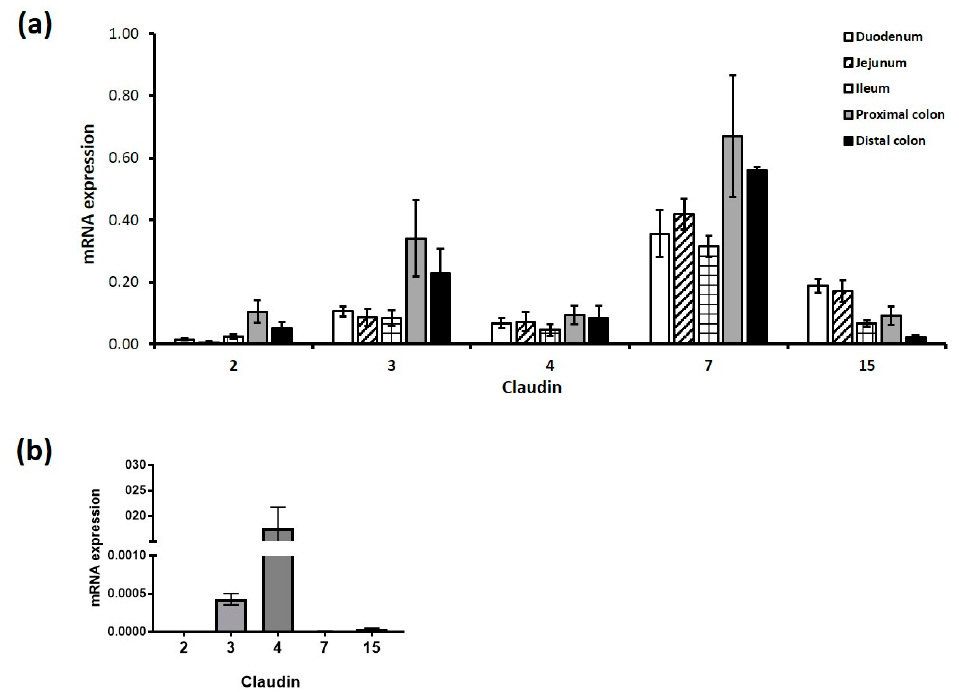
Figure 3. Claudin mRNA expression profile in the intestinal epithelium in vitro and in vivo. Claudin mRNA transcripts were profiled in the small and large intestine and in cultured Caco-2 cells. ( a ) Three segments of the murine small intestine, the duodenum (stomach to ligament of Treitz), the jejunum (ligament of Treitz until mid-small intestine), the ileum (remaining half of small intestine until the caecum), and two segments of the large intestine (proximal (first half of the colon) and distal colon (second half of the colon)) were collected for RT-PCR analysis. ( b ) Untreated Caco-2 cells were collected for RT-PCR analysis. The relative ratio was calculated as claudin compared to actin mRNA expression levels. Data are expressed as the mean ± S.E.M of PCR reactions. n = 6.